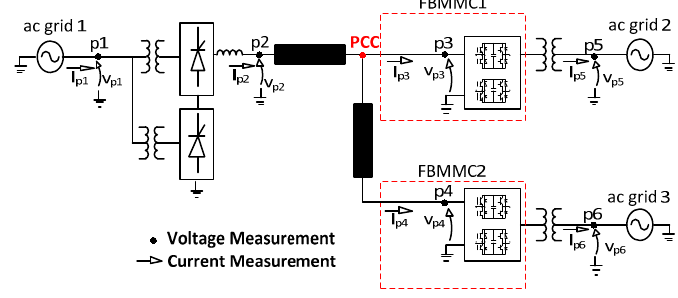
Figure 2. Analyzed Hybrid HVDC system topology.